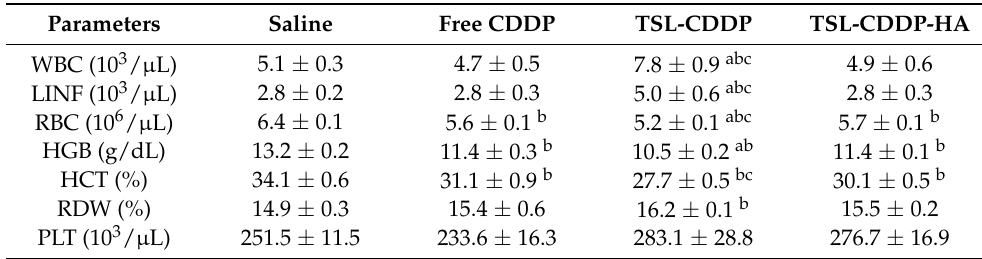
Data represented as mean ± standard error of mean ( n = 6 animals), except for free CDDP ( n = 5). a represents significant difference compared to the TSL-CDDP-HA group. b represents significant difference compared to the saline group. c represents significant difference compared to the free CDDP group. p < 0.05 (Tukey test). Abbreviations: WBC: white blood cell count; LYMP: lymphocytes; RBC: red blood cell count; HGB: hemoglobin; HCT: hematocrit; RDW: distribution of red blood cells; PLT: platelet